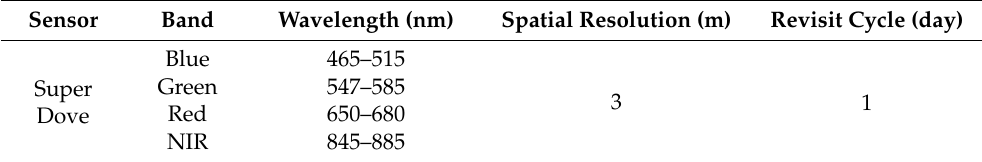
Table 1. Attributes of the Super Dove sensor.